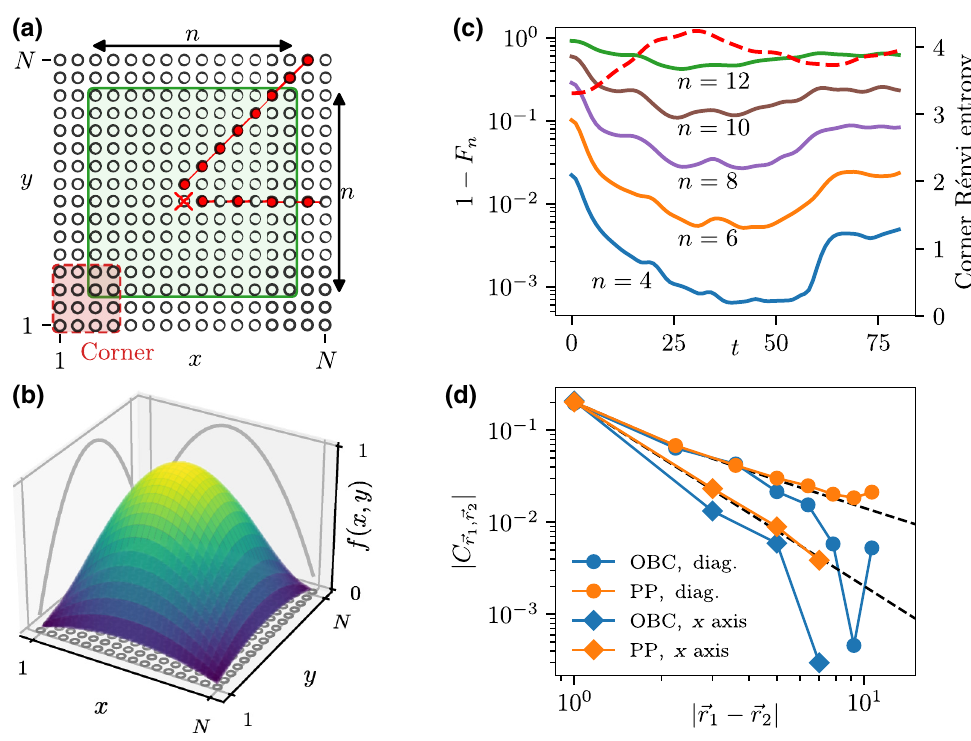
FIG. 7. Purification preparation for free fermions on a two-dimensional (2D) square lattice. (a) Schematic representation of the lattice with the linear size N = 16 used in our numerical simulations. The green solid rectangle indicates the bulk subsystem n × n with n = 12. The red dashed rectangle shows the 4 × 4 corner region chosen to measure the second Rényi entropy S ( 2 ) during the PP. (b) Deformation f ( x , y ) [Eq. (17)] used in the Hamiltonian [Eq. (16)] for the PP dynamics. Gray parabolic curves show projections of f ( x , y ) onto the x / y directions. (c) Evolution of the infidelity [Eq. (10)] for the bulk subsystems of several sizes n , and of the second Rényi entropy S ( 2 ) in the corner region indicated in (a) during the PP dynamics. (d) Decay of two-point correlators [Eq. (18)] in the OBC and PP states along the x axis and along a diagonal. (cid:17) r 1 is fixed and is given by a red cross in (a). {(cid:17) r 2 } are given in (a) by red bullets connected by red lines to indicate both correlator sets. Dashed lines give the correlators in the infinite state.